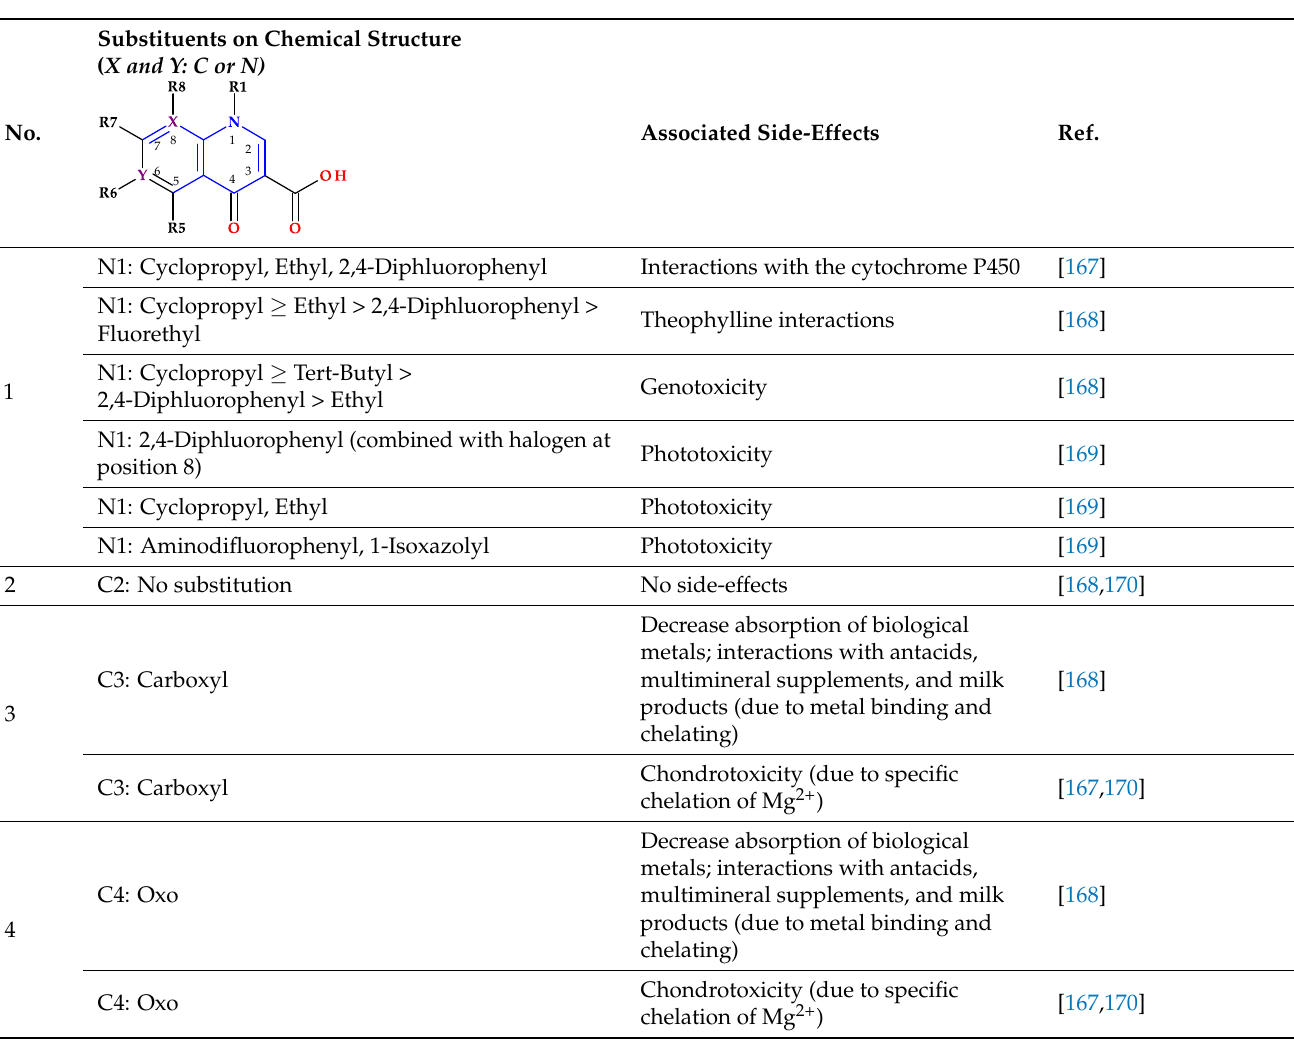
Table 5. Relationships between chemical structure and side-effects of FQs (FQs — fluoroquinolones, GABA — gamma-aminobutyric acid, NSAIDs — non-steroidal anti-inflammatory drugs, Ref. — Refer-